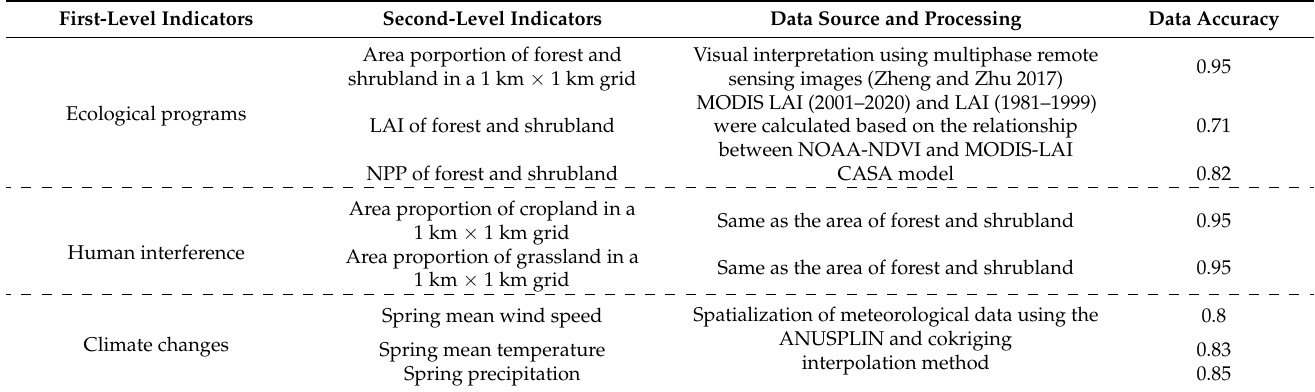
Table 3. Driving factors and data